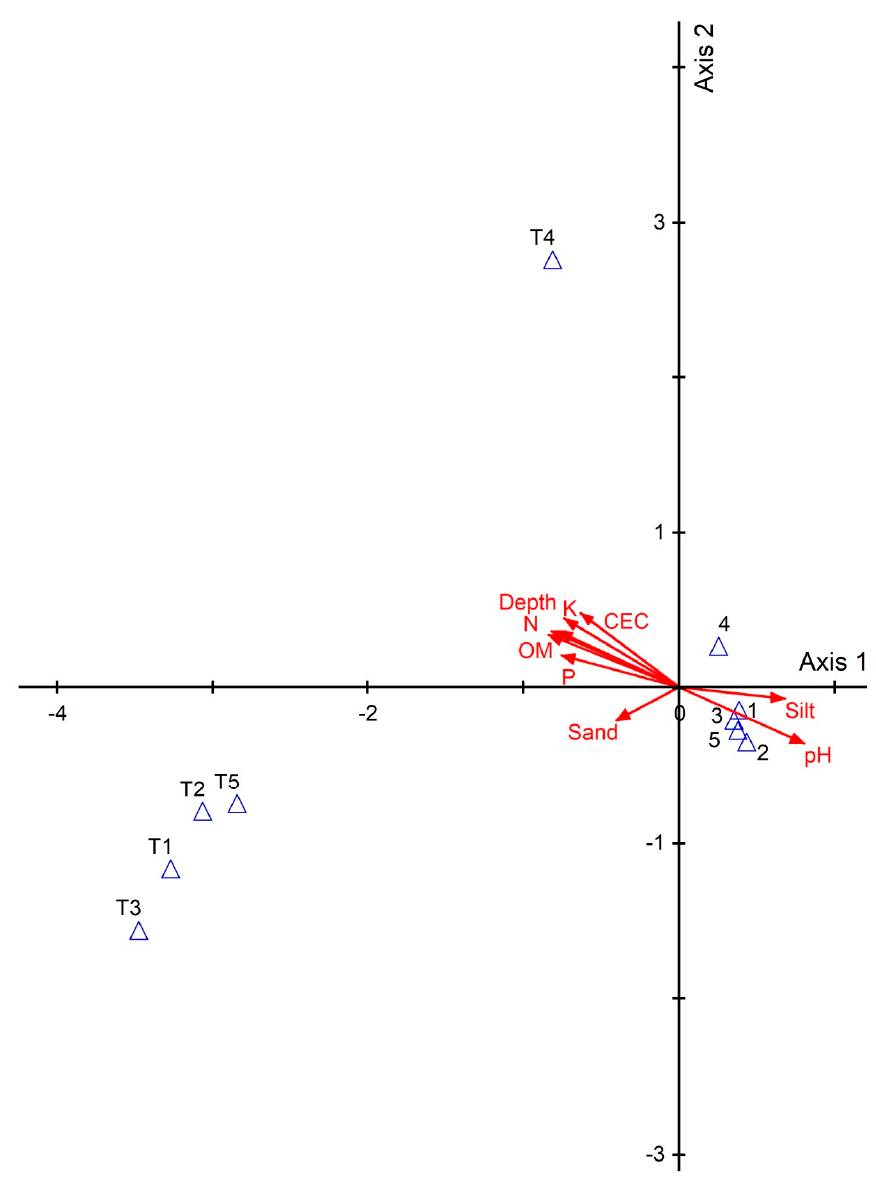
Figure 3. Canonical Correspondence Analysis (CCA) biplot of plots and soil variables. T = target vegetation, 1–5 quarries. Depth refers to the soil depths of plots, OM = organic material, N = nitrogen, P = phosphorus, K = potassium, CEC = cation exchange capacity.